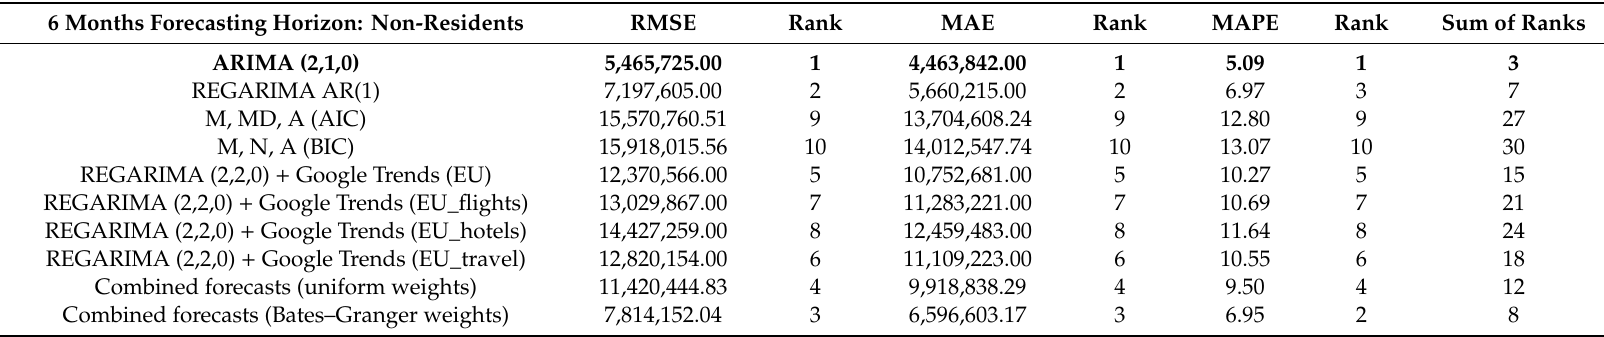
Table A6. Forecasting accuracy (December 2017): overnights, non-residents, six months ahead. Source: European Commission (2017) and own calculations. Boldface indicates the single forecasting model(s) / forecast combination technique(s) characterized by the lowest sum of ranks. 6 Months Forecasting Horizon: